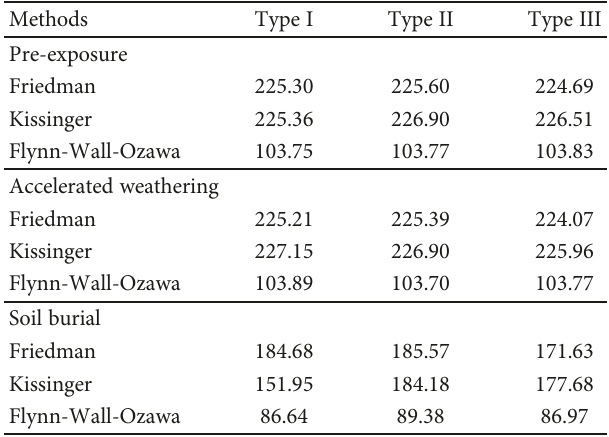
Table 5: Summary of apparent activation energy ( E values estimated from the various methods in this